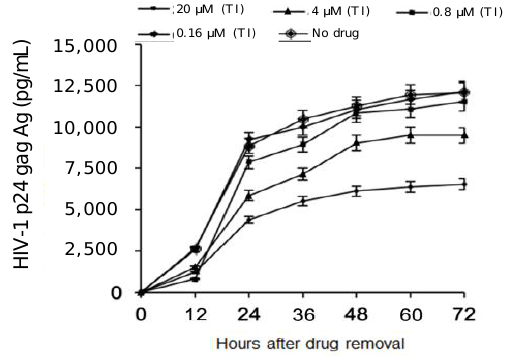
Figure 3. Kinetics of HIV-1 p24 rebound after AMP removal. HIV-1 p24 was measured in culture supernatants at 12, 24, 48 and 72 h after drug-removal from the supernatants of HIV-1 chronically-infected MDM. TI: treatment-interruption.